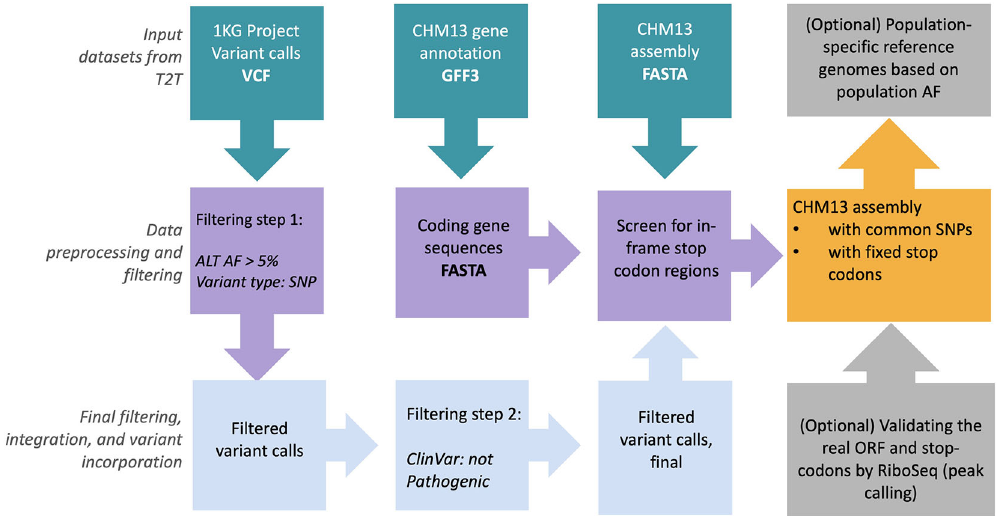
Figure 8. Overview of the reference panel generator pipeline for revising CHM13 reference panel. CHM13 genome sequence (FASTA), gene annotations (GFF3), and combined 1000 Genomes Project single nucleotide variants (SNVs) and insertion/deletion (INDEL) call sets in variant call format (VCF) are retrieved from Amazon- AWS 127 (RRID:SCR_012854) cloud. Only common alleles (>5% allele frequency (AF)) in the variant call set are retained. ClinVar 128 database was used to annotate variant calls with any clinical significance. Subsequently, common allele calls are replaced with CHM13 rare alleles in CHM13 FASTA genome sequence. Finally, screen-out in-frame stop- codon sites from genome sequence in order to generate the final reference panel files in FASTA